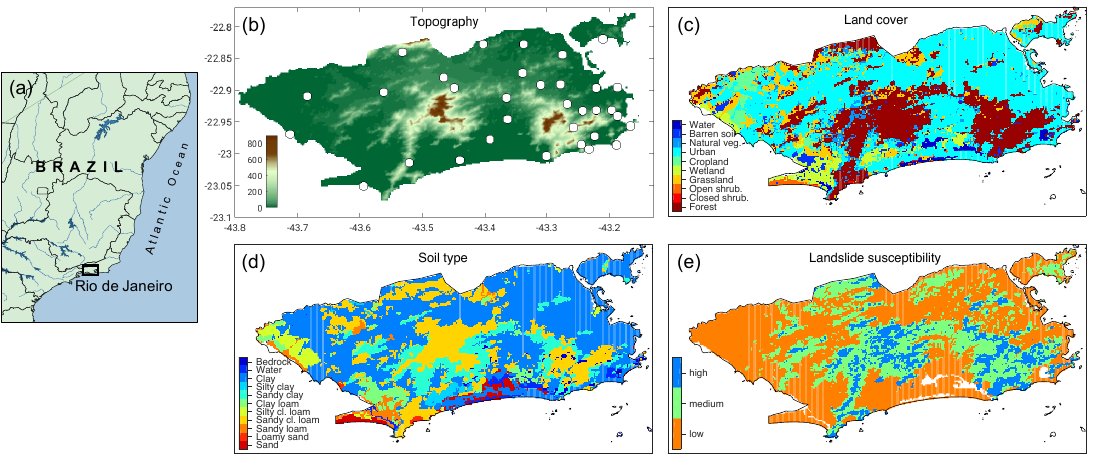
Figure 1. Study area / geographic location, and land surface datasets available for Rio de Janeiro city: ( b ) topography, ( c ) land cover, ( d ) soil type and ( e ) landslide susceptibility maps. The spatial distribution of pluviometric stations is also provided in panel ( a